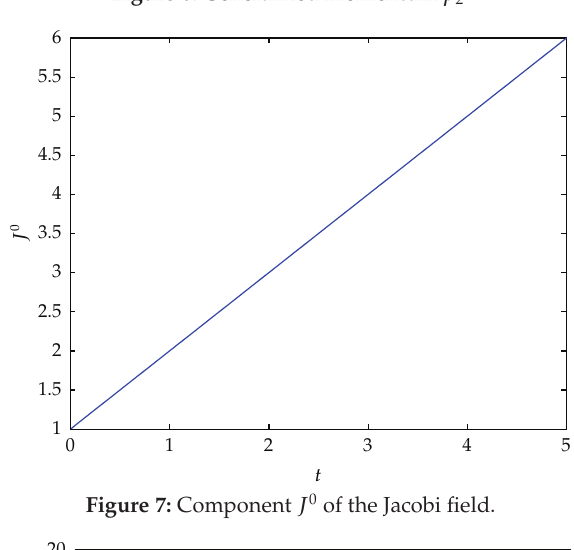
Figure 7: Component J 0 of the Jacobi field.